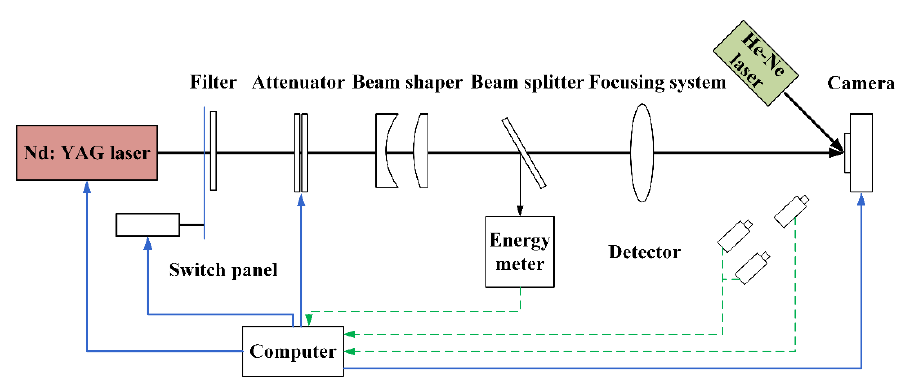
Figure 2. Laser damage threshold test system.